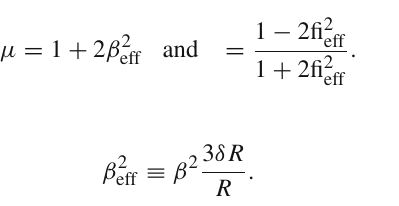
a dense region to a less dense region that matters rather than the dense region